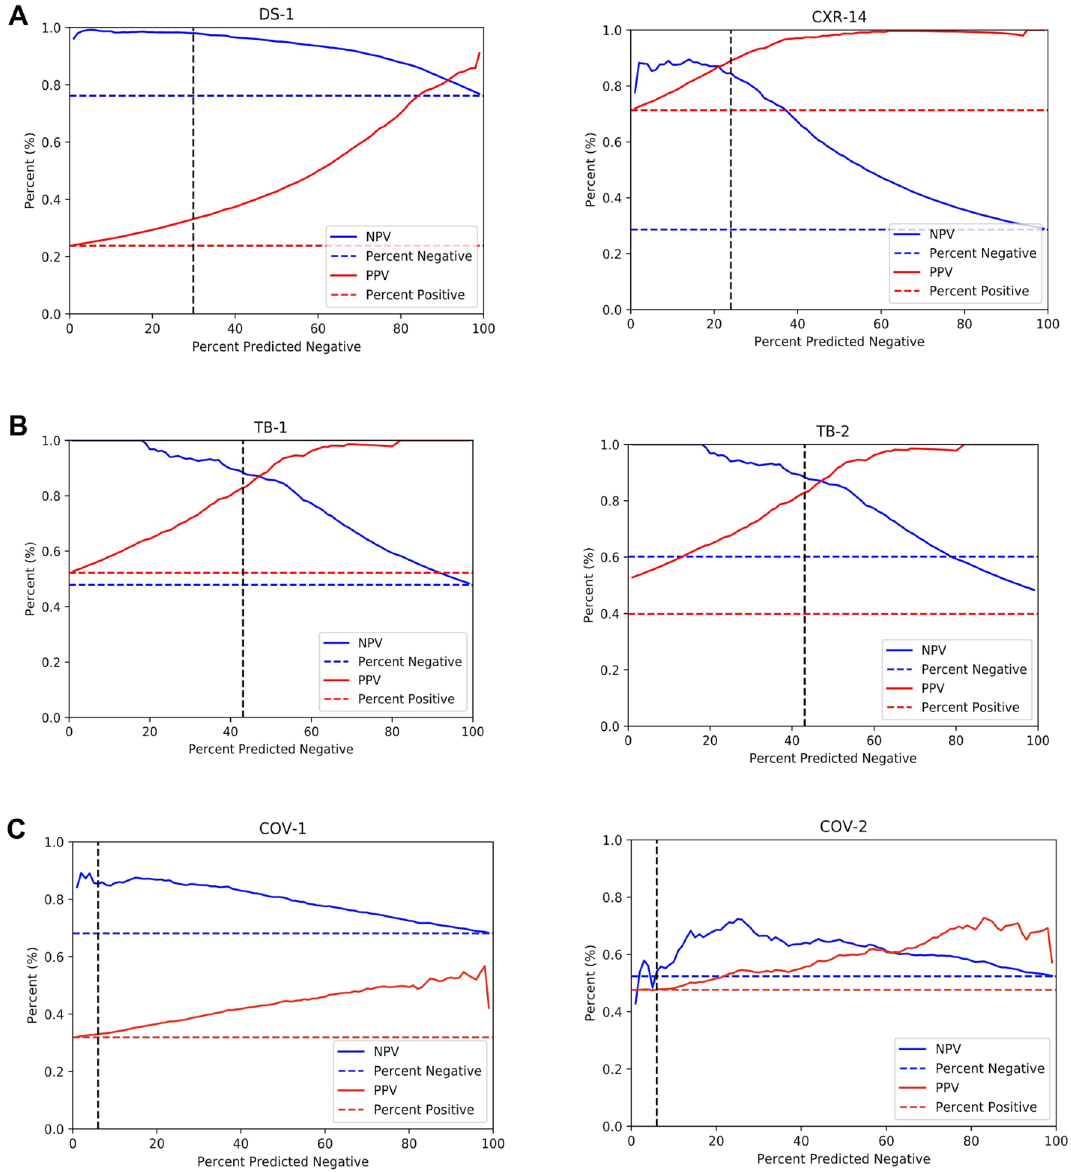
Figure 3. Positive predictive values (PPV) and negative predictive values (NPV) of the DLS across 6 datasets. ( A ) General abnormalities: DS-1 and CXR-14 datasets. ( B ) TB: TB-1 and TB-2. ( C ) COVID-19: COV-1 and COV-2. The horizontal dotted lines represent the prevalence of positive examples (red) and negative examples (blue), which also correspond to random predictions’ PPV and NPV, respectively. The DLS’s NPV converges to the prevalence of negative examples when all examples are predicted as negative, and the DLS’s PPV converges to the prevalence of positive examples when all examples are predicted as positive. The vertical, dotted black lines highlight the selected operating point at 95% sensitivity on the operating point selection sets for each